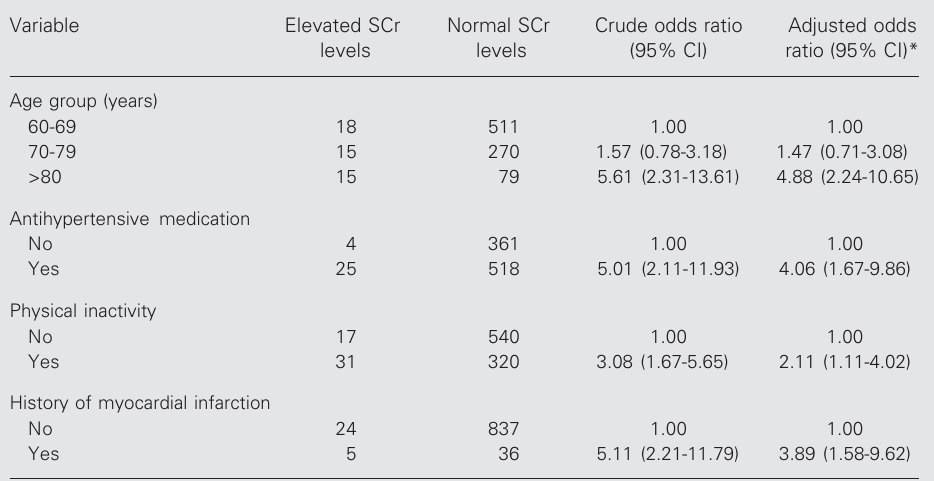
Table 4. Predictors of elevated serum creatinine (SCr) levels for women (SCr (cid:2) 1.1 mg/dl) in the multivariate analysis (Bambuí Health and Ageing